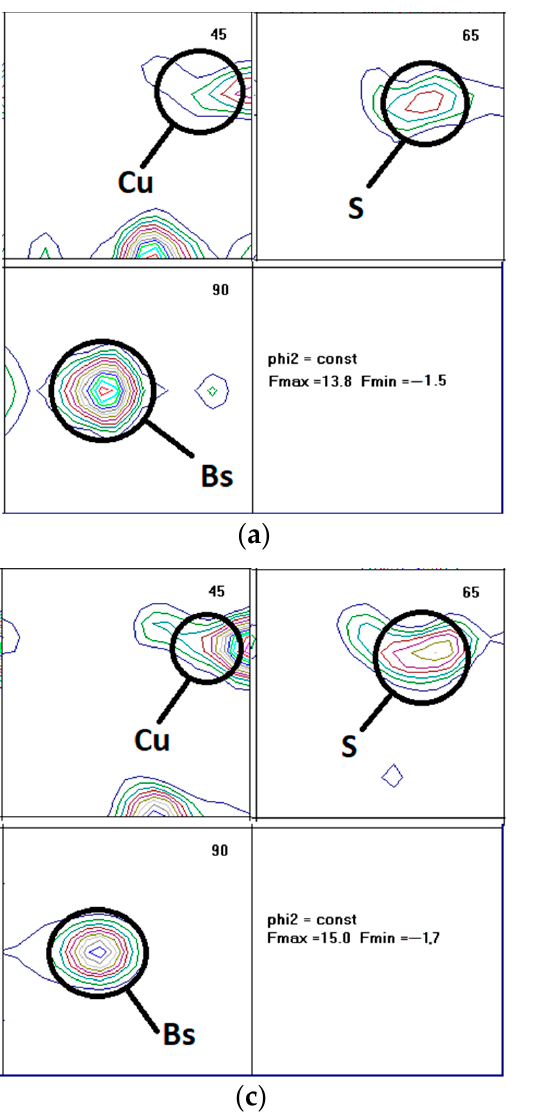
Figure 6. ODF , Al + 1% Mg (composition, see Table 2) compressed under plain strain to 80% engineering strain ( a ) strain rate 1 s − 1 , temperature 300 °C, ( b ) strain rate 1 s − 1 , temperature 450 °C, ( c ) strain rate 10 s − 1 , temperature 300 °C ( d ) strain rate 10 s − 1 , temperature 450 °C.